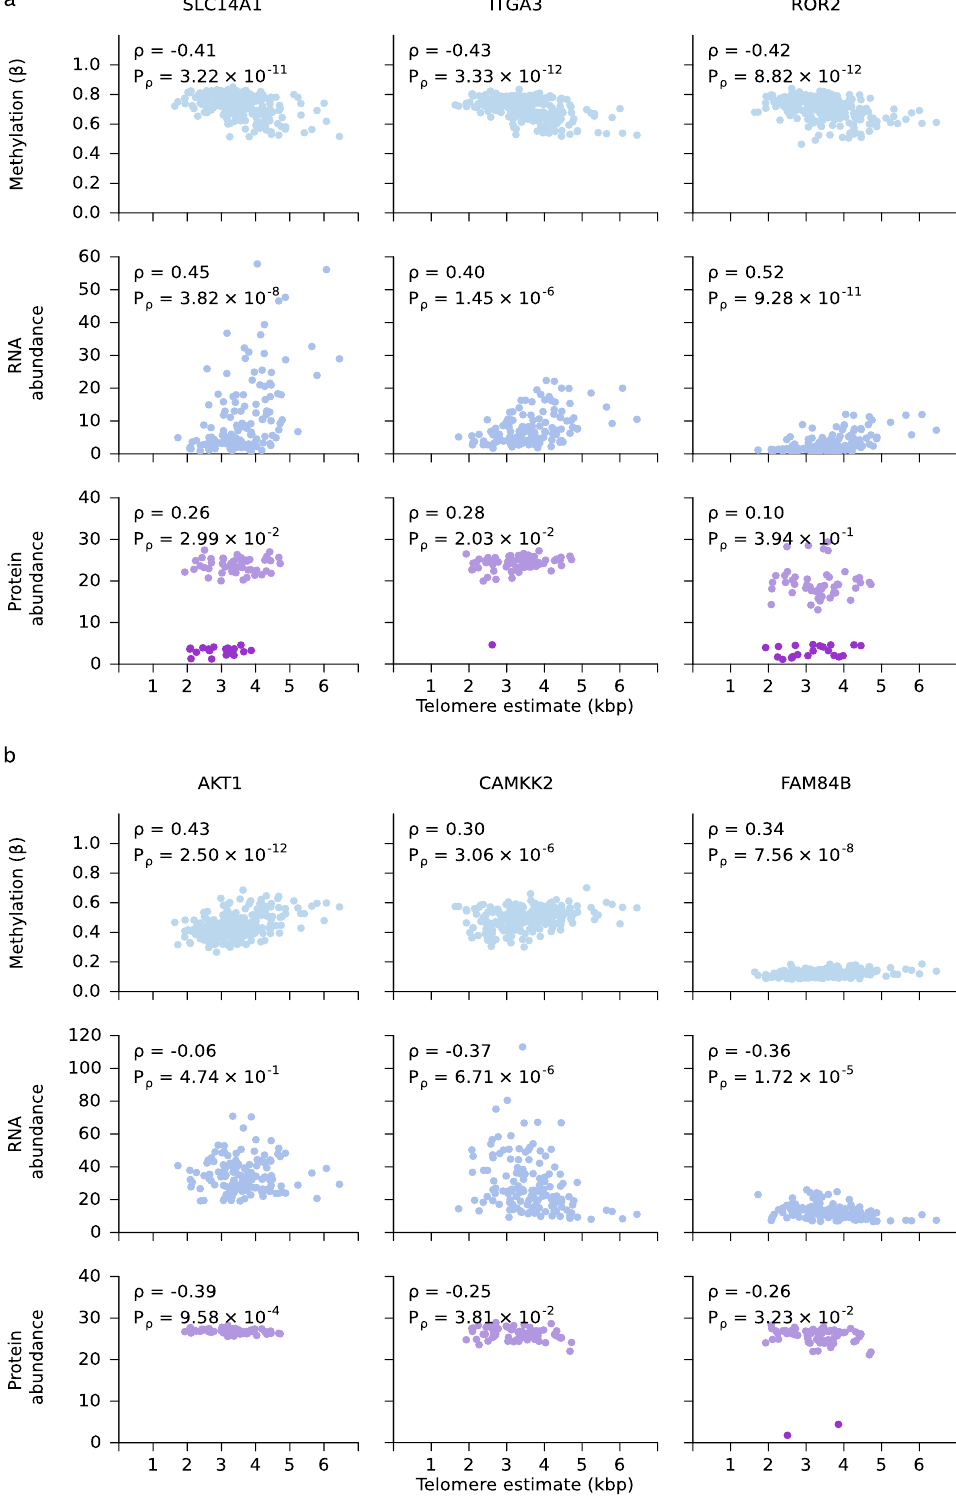
NATURE COMMUNICATIONS| (2021) 12:6893